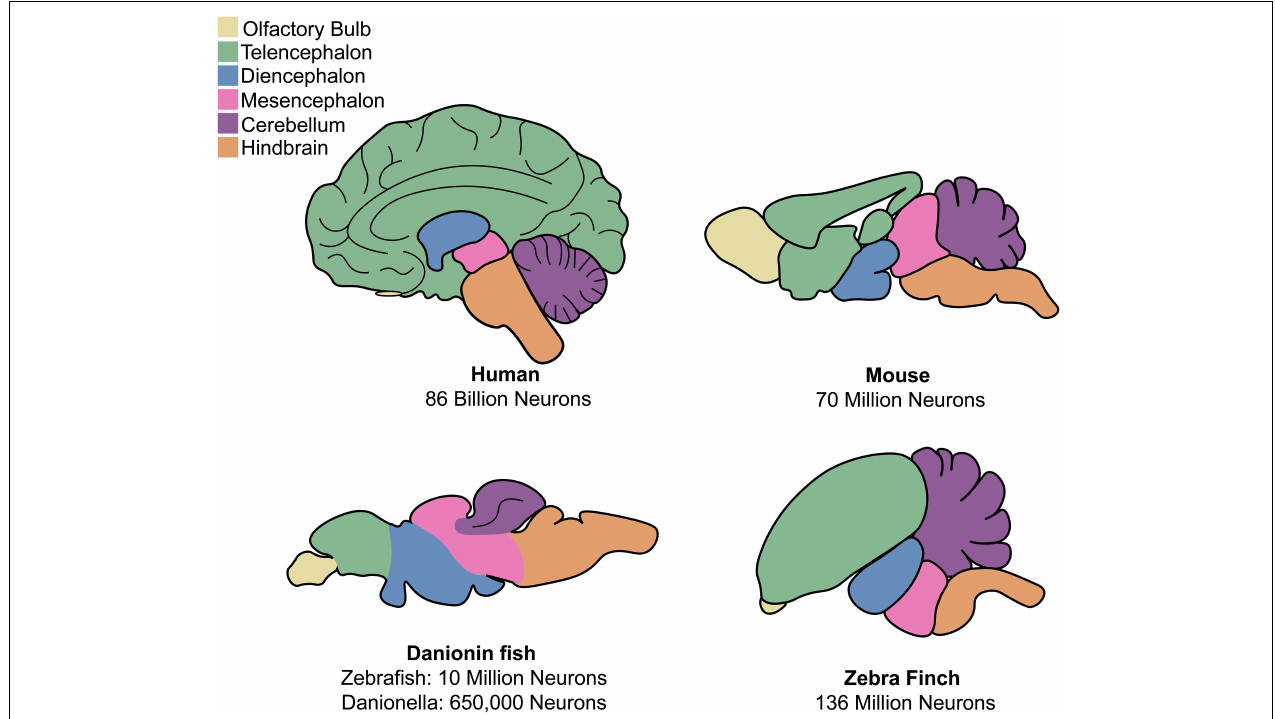
FIGURE 1 | Comparison of anatomy for mammalian and discussed non-mammalian vertebrates. Both mammalian and non-mammalian vertebrates share similar brain anatomy, though region size and organization varies greatly between